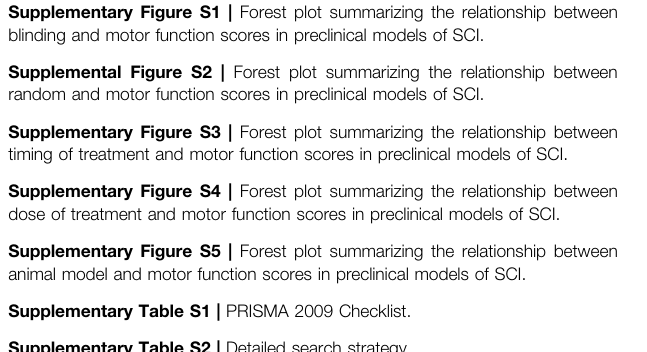
Supplementary Table S1 | PRISMA 2009 Checklist. Supplementary Table S2 | Detailed search strategy. Supplementary Table S3 | Raw data fi